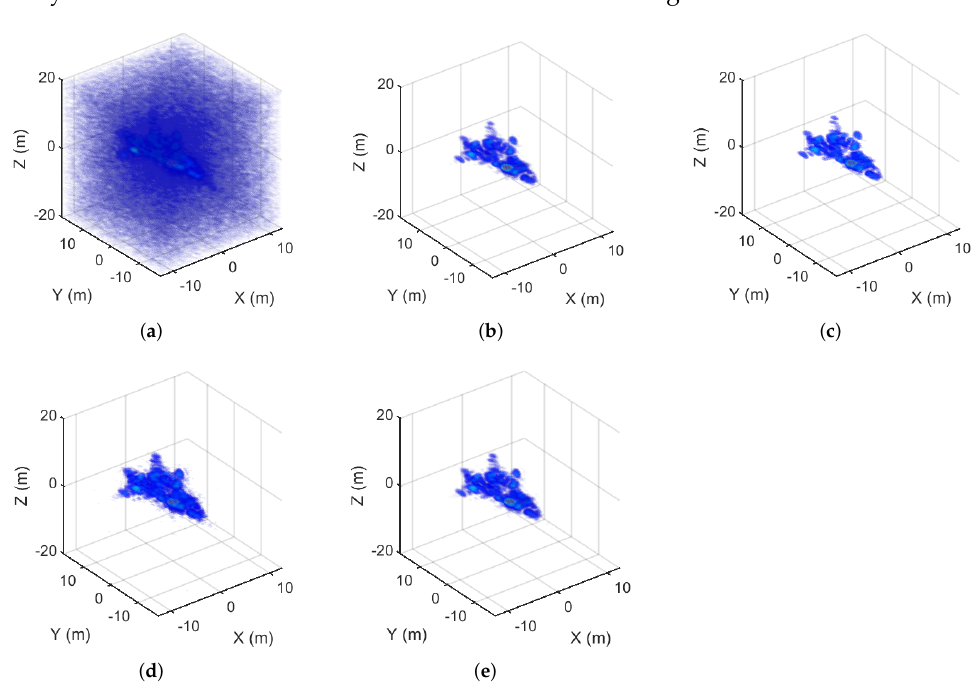
Figure 4. The imaging results of the aircraft corresponding to the 100% sampling rate. ( a ) The